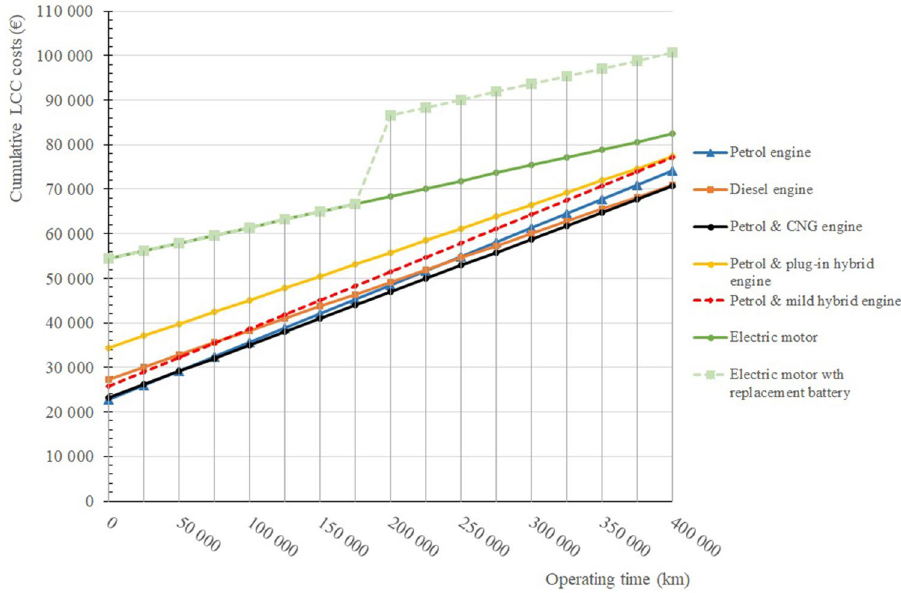
Figure 10. Cumulative life cycle costs of selected passenger car powertrains.